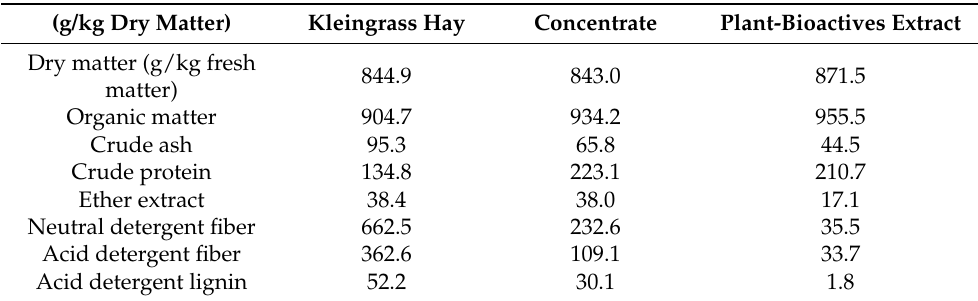
Table 1. Chemical composition of ration and plant-bioactives extract (g/kg of dry matter) used in 24 h In Vitro